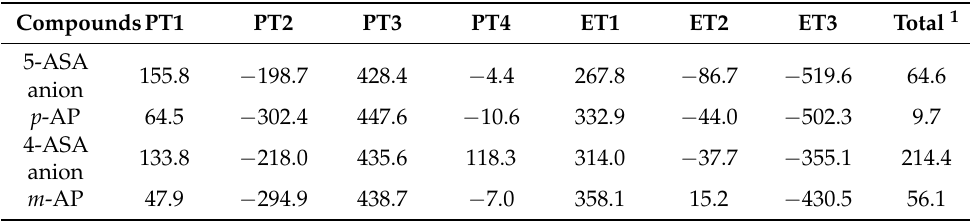
Table 1. ∆ G ◦ values (kJ mol − 1 , 298.15 K) for PCET between O 2 •− and the four aminophenols in DMF, calculated using DFT at the B3LYP/PCM/6-311+G(d,p)